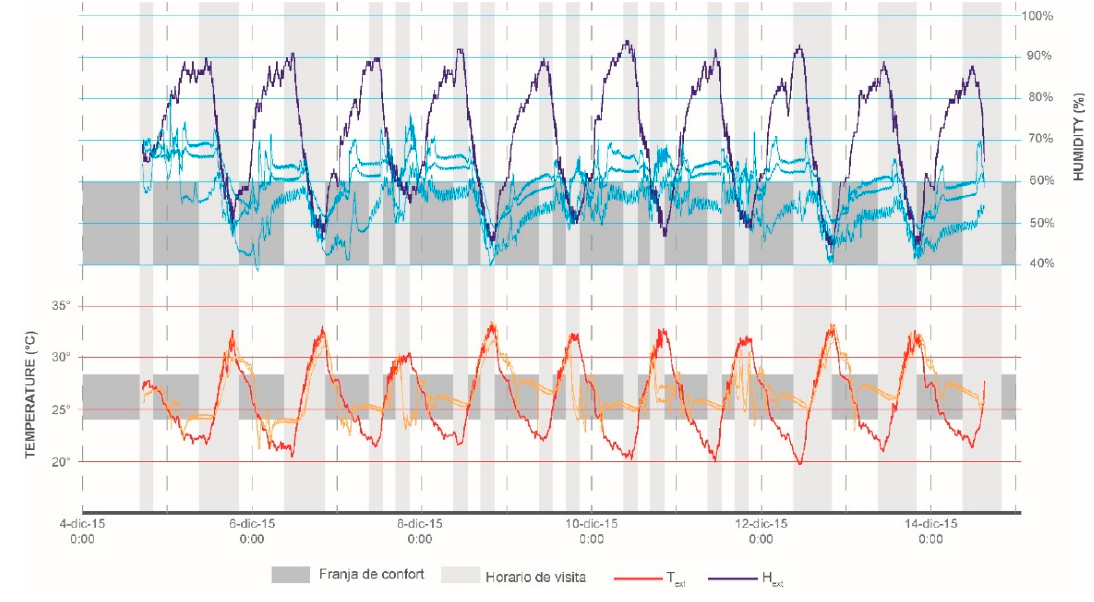
Figure 22. Graph of hygrothermal behavior. Table 6. Percentage of Hours (in scoring hours) in Comfort Range. TEMP. HUM. REL.